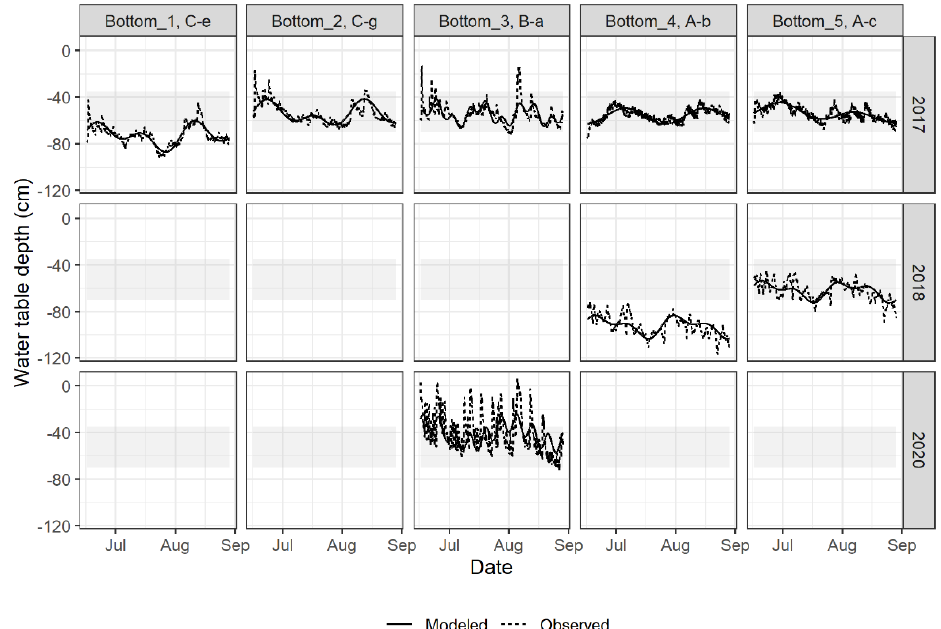
Figure 3. Observed and modelled time series of WTDs using multi-frequential periodogram for the Bottom sites and years meeting the required water management conditions (controlled drainage or subirrigation).